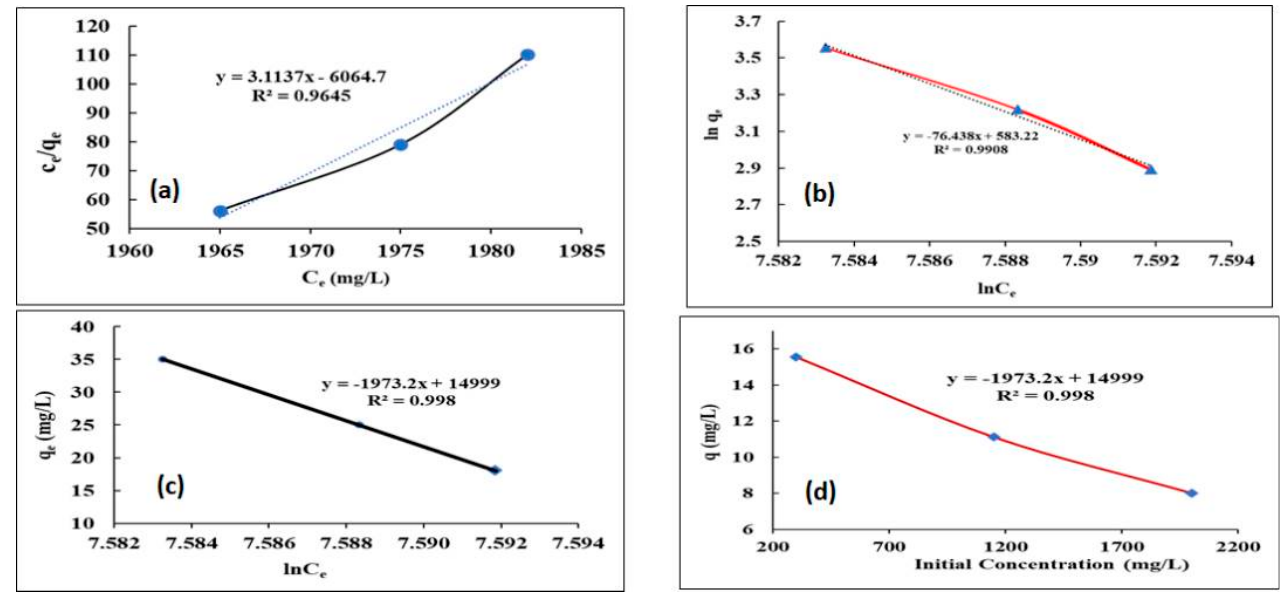
Figure 8. The adsorption isotherms of B fitted lines with the ( a ) Langmuir ( b ) Freundlich ( c ) Temkin ( d ) Effect of the initial concentration on the boron adsorption. Table 6. Comparison of the isotherm’s parameters.